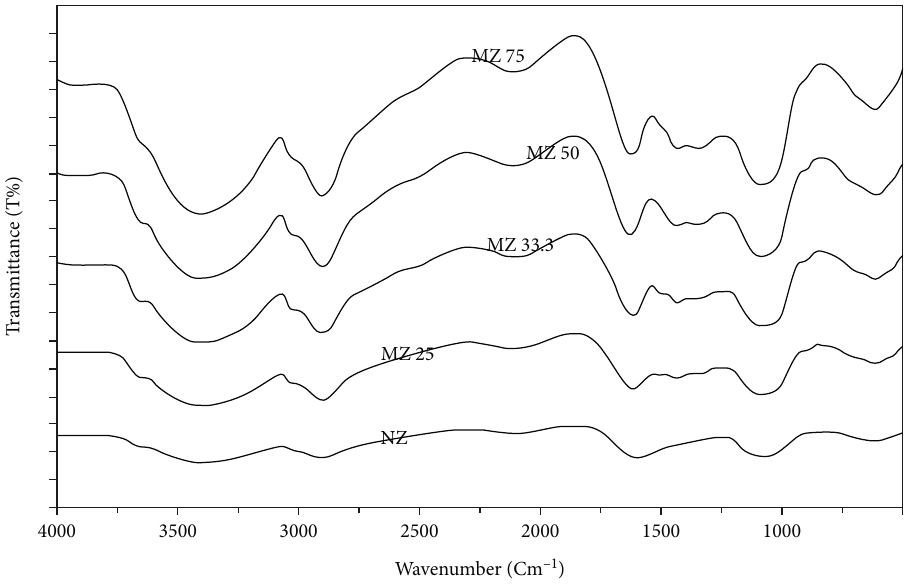
Figure 3: FTIR spectra of NZ, MZ25, MZ33, MZ50, and MZ75